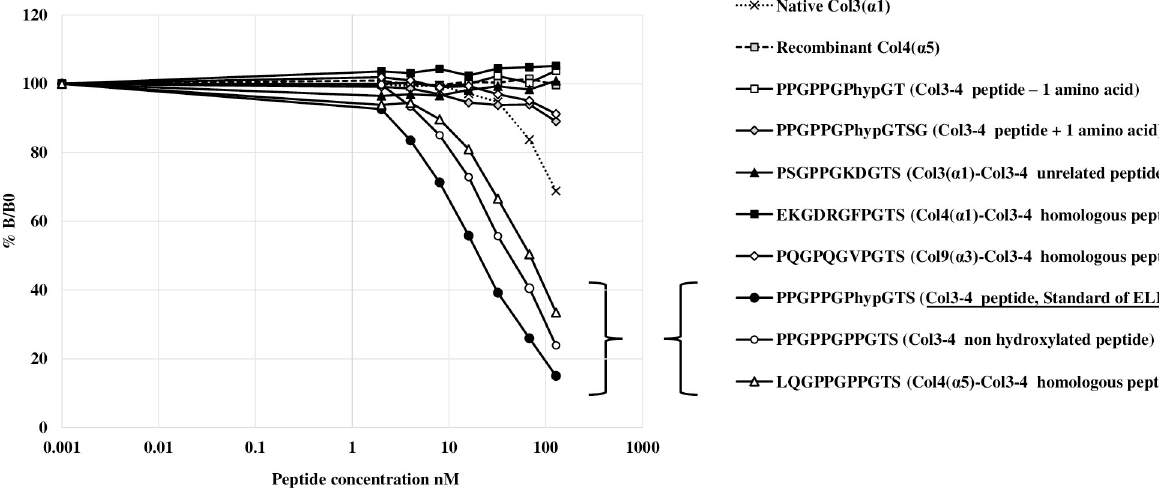
Fig 2. Specificity of the Col3-4 ELISA for collagen peptides and intact collagen molecules. The graph shows the competitive inhibitions between Col3-4 peptide, standard of ELISA with the following derived peptides for binding to the ELISA antibody 1) extended Col3-4 peptide (Col3-4 peptide + 1 amino acid), 2) shortened Col3-4 peptide (Col3-4 peptide—1 amino acid), 3) non-hydroxylated Col3-4 peptide (Col3-4 non-hydroxylated peptide), 4) unrelated type III peptide (Col3( α 1)-Col3-4 unrelated peptide), 5) homologous type IV ( α 5) collagen peptide (Col4( α 5)-Col3-4 homologous peptide), 6) homologous type IX ( α 3) collagen peptide (Col9( α 3)-Col3-4 homologous peptide), 7) homologous type IV ( α 1) collagen peptide (Col4( α 1)-Col3-4 homologous peptide). The graph shows also the recognition of the antibody with intact type III ( α 1) collagen (Native Col3 ( α 1)) and type IV ( α 5) collagen (Recombinant Col4 ( α 5). Y-axis shows the relative binding of the antibody at different concentrations of each molecule (B) expressed as a percentage of the binding with no competitor peptide (B0). The x-axis shows the molar concentration of each peptide. In brackets are the immunoreactive